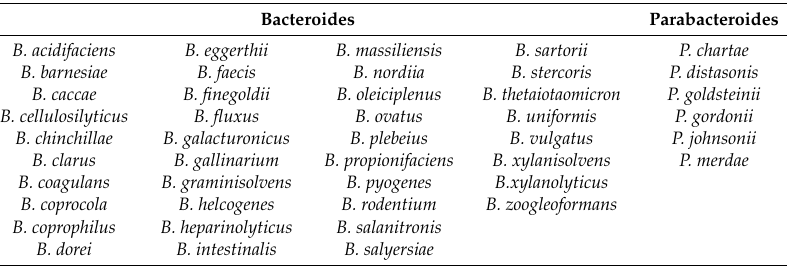
Table 2. Species of the Bacteroides fragilis group